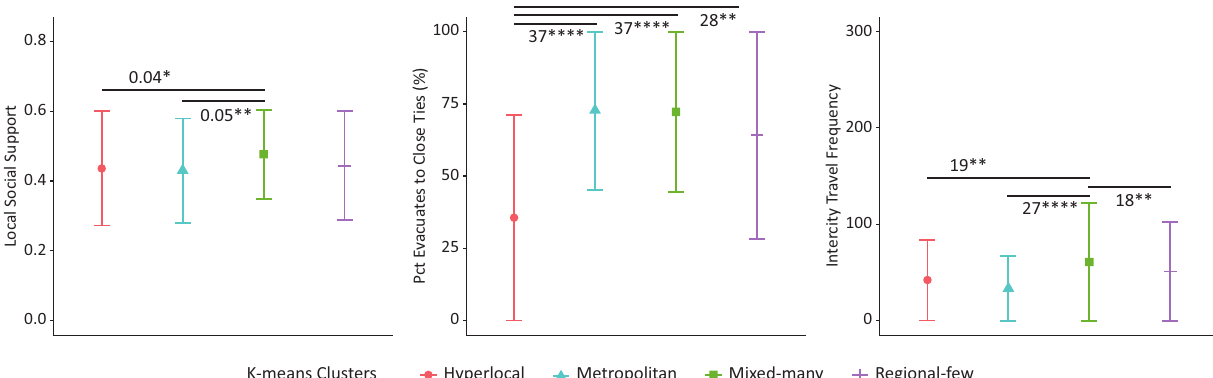
Figure 4. Mean and standard deviations of local social support, percentage of people that could leave to the locations of close friends and families, and intercity travel frequency for each extensibility type. Notes: The y axis scales with the minimum and maximum value in a behavioral factor; a black line between any two clusters signals a statistically‐significant relationship and is annotated with the absolute value of the mean difference between those two clusters at either end of the black line; the statistical significance of the mean difference is tested with ANOVA multiple comparisons (Tukey HSD); the p‐value is adjusted by Bonferroni correction (*p < 0.05; **p < 0.01; ***p < 0.001; ****p <